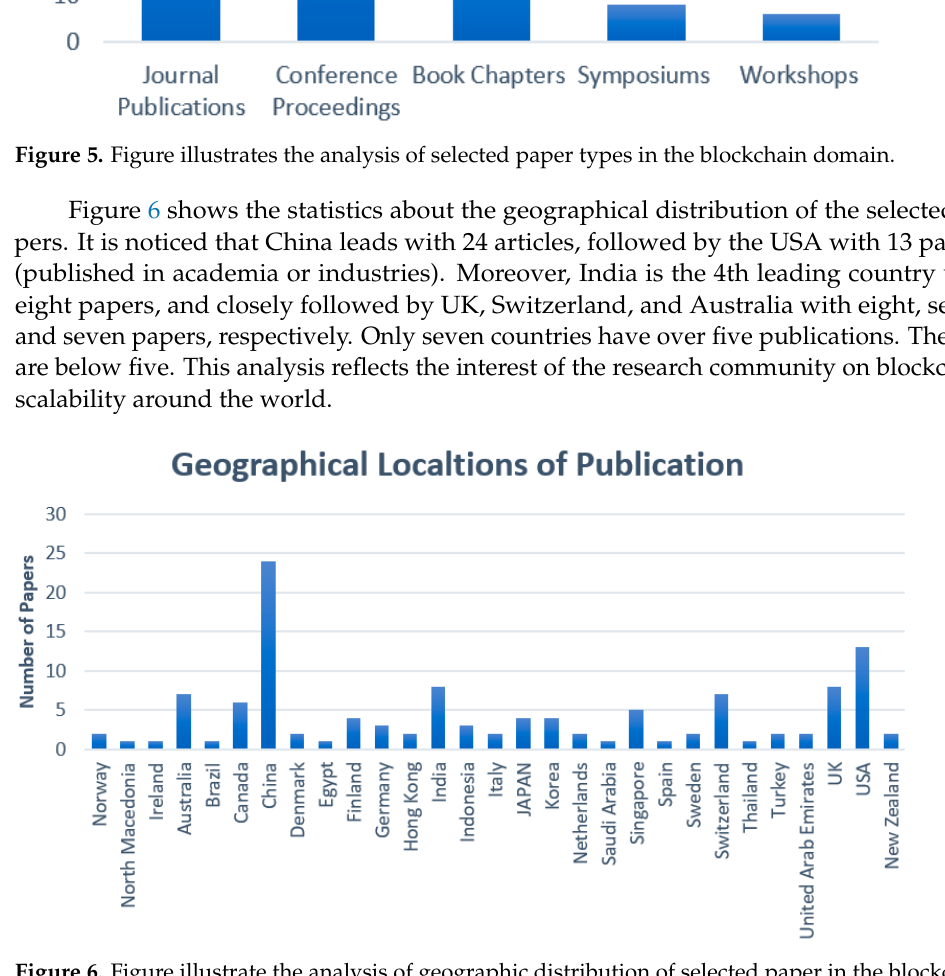
Figure 6. Figure illustrate the analysis of geographic distribution of selected paper in the blockchain domain.